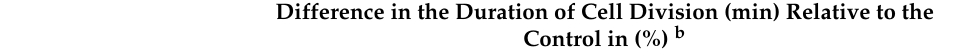
Table 4. The effect of compounds 11 , 13 and 15 on the duration of cell division of HaCaT and SCC cells a . Difference in the Duration of Cell Division (min) Relative to the Control in (%)